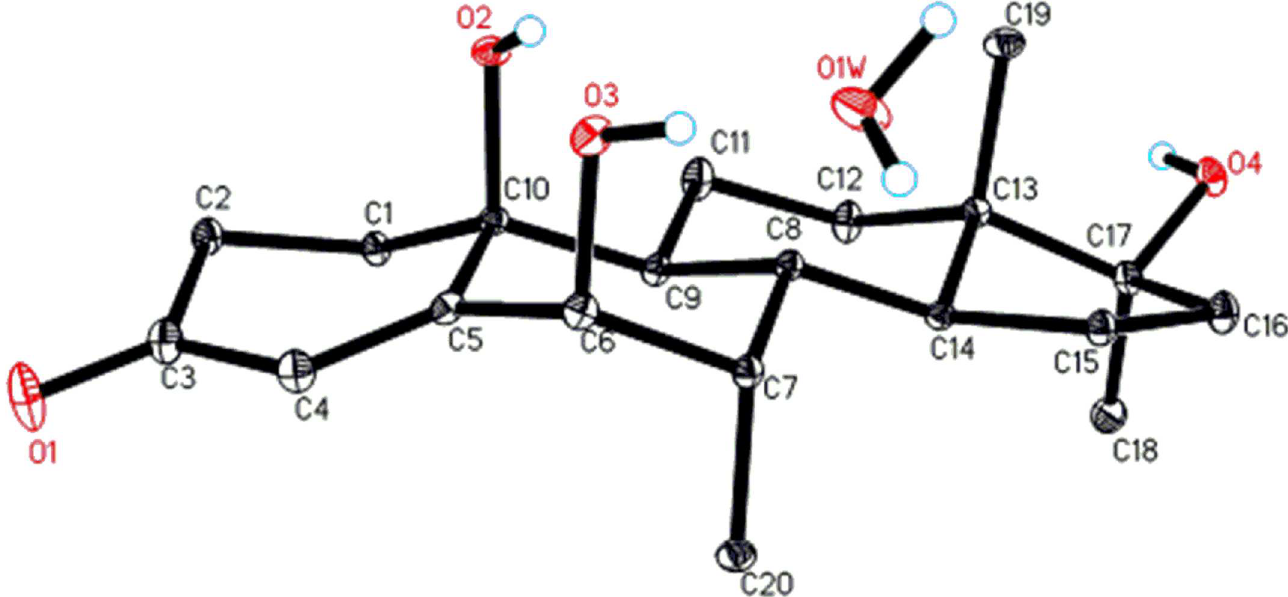
Fig 7. ORTEP drawing of X-ray structure of compound 4. Water appearedas solvent of